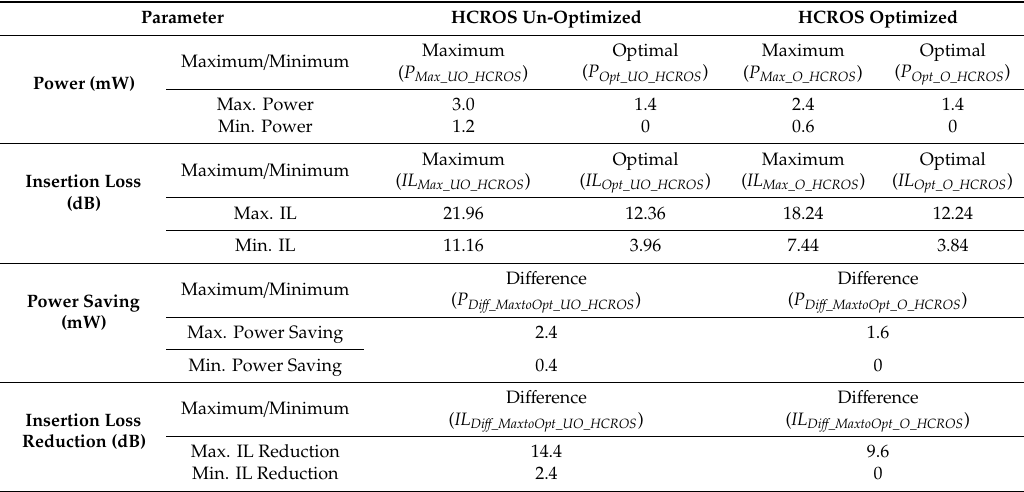
Table 13. Maximum/minimum power consumption with power saving and maximum/minimum insertion loss with reduction for 720 I/O links.